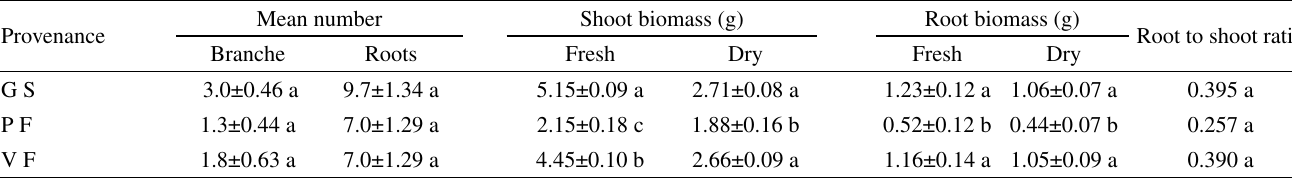
Table 4 - Morphological characteristics of Picea abies seedlings grown in pots outdoors Provenance